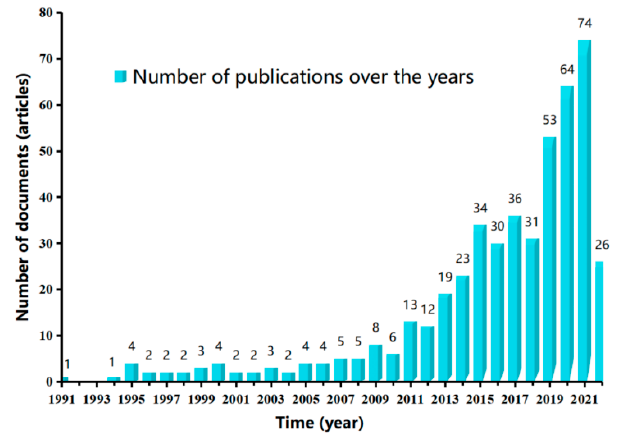
Figure 3. Publication volume over time.